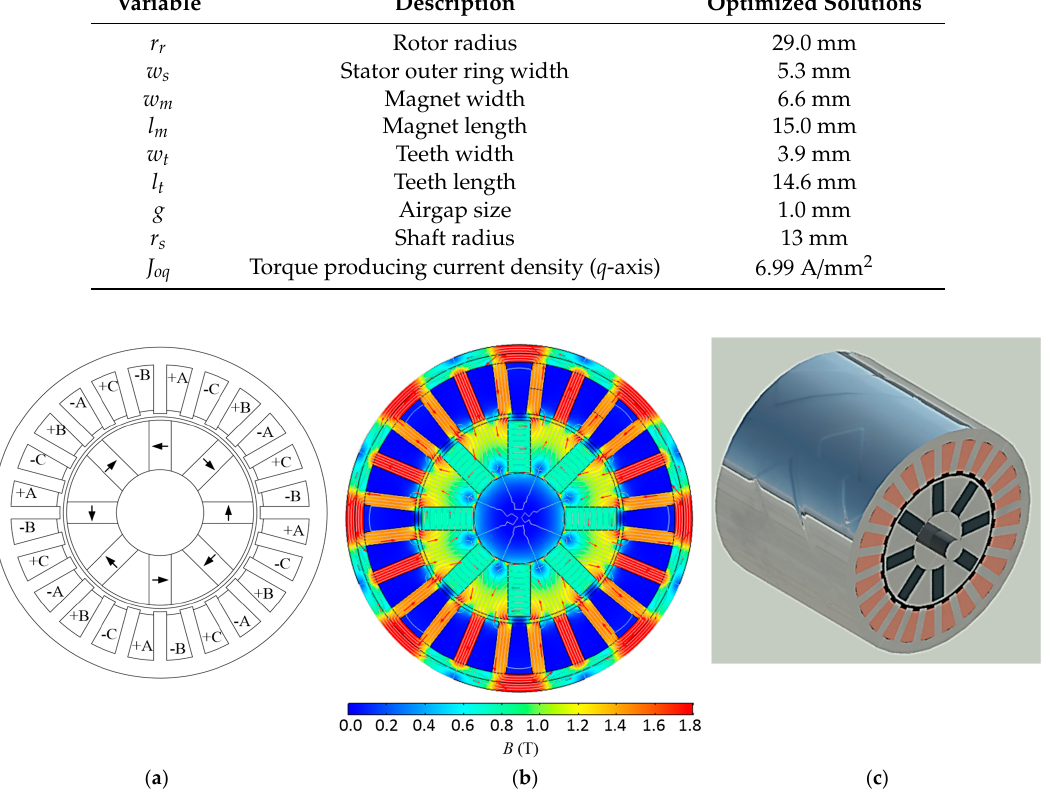
Table 8. Optimization decision variables.